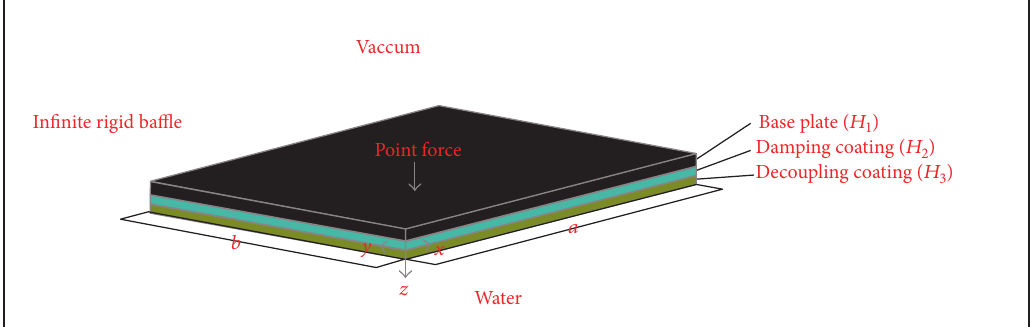
Figure 1: Schematic illustration of the resonant structure